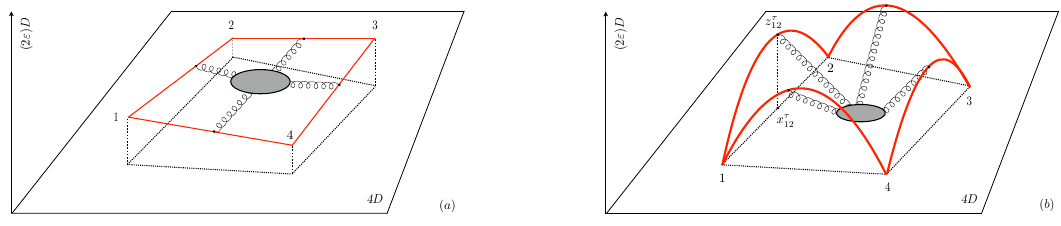
Figure 1 . Schematic drawing of the D = 4 + 2 ε dimensional contour of the off-shell Wilson loop in (a) and its representation in (b) after imposing the light-like conditions (2.3) and (2.8) and dimensional reduction of the interior to four